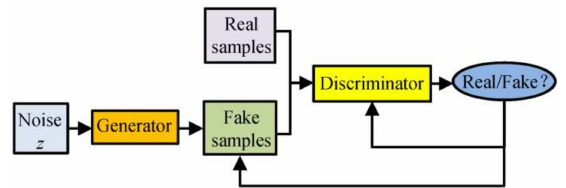
Figure 3. The structure of the GAN